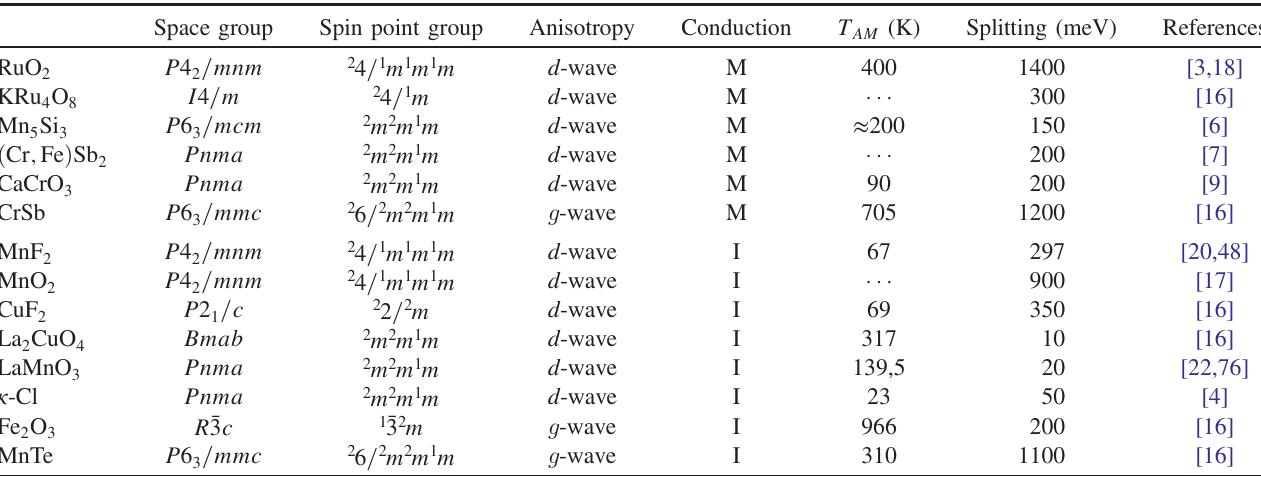
TABLE III. Altermagnetic candidates identified from ab initio calculations. We list the nonmagnetic space group, spin point group, even-parity wave anisotropy, metallic (M) or insulating/semiconducting (I) conduction type, altermagnetic transition temperature, and altermagnetic spin-splitting magnitude and anisotropy type.